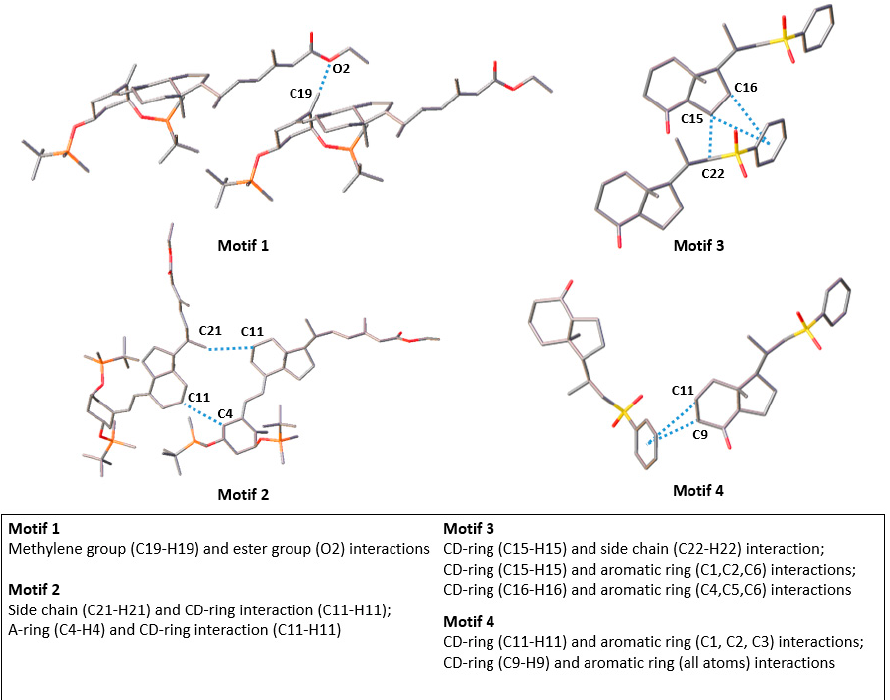
Figure 4. Selected interactions in BNR-1 (motifs 1 and 2) and Syn-1G (motifs 3 and 4). The most important carbon and oxygen atoms are captioned. The H-atoms were omitted for clarity; however, the numbering of H-atoms corresponds to the numbering of carbon atoms.